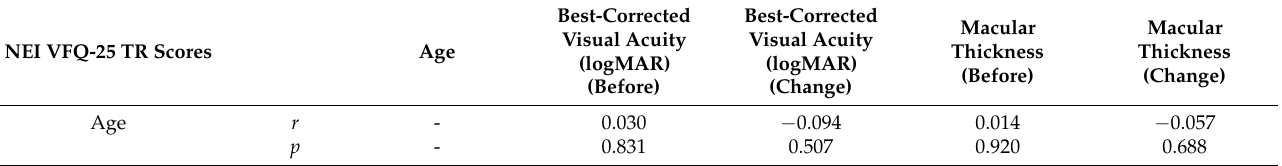
Table 8. The correlations of different variables with the changes in NEI VFQ-25 TR subscale and composite scores.